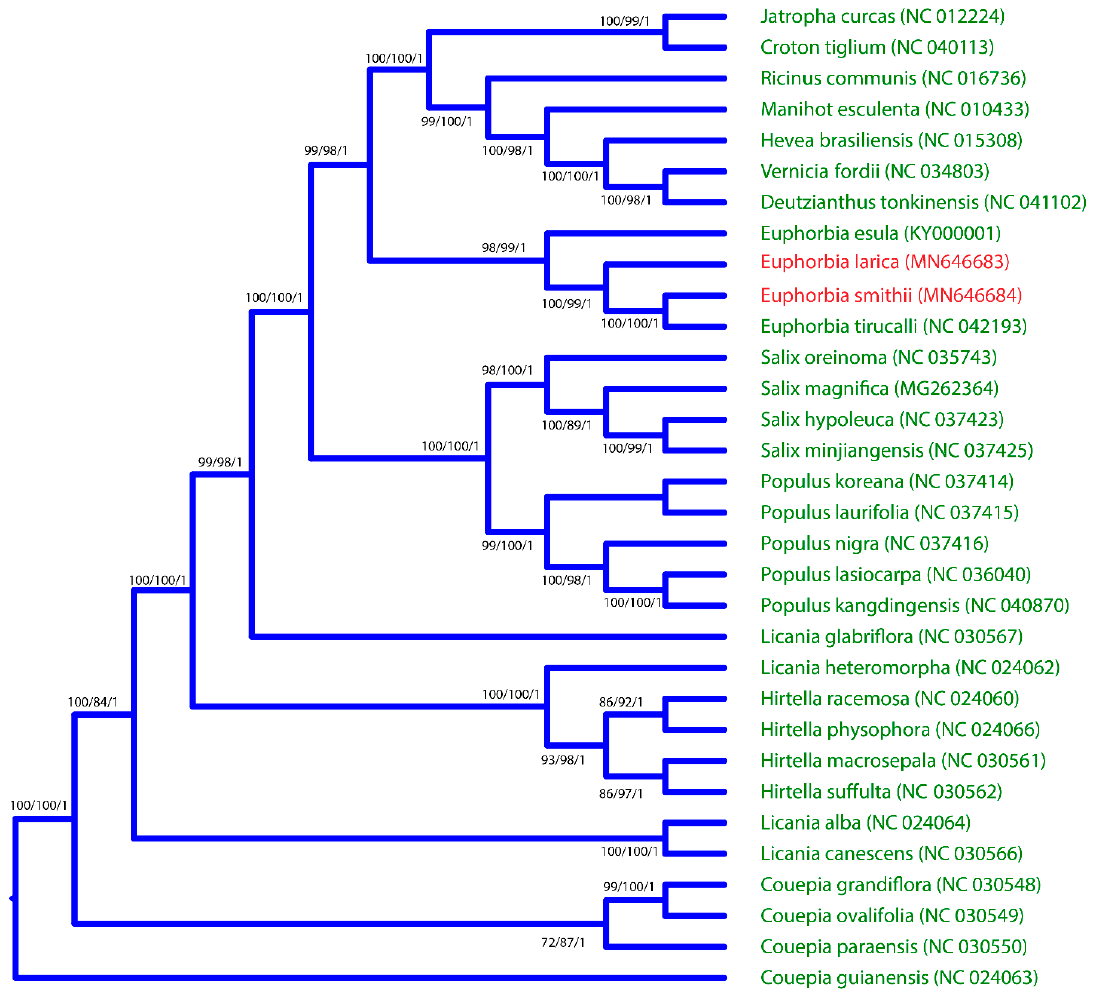
Figure 6. Phylogenetic trees of E. smithii and E. larica . The entire genome dataset was analyzed using three different methods: Bayesian inference (BI), maximum parsimony (MP), and maximum likelihood (ML). Numbers above the branches represent bootstrap values in the ML and MP, and posterior probabilities in the BI trees. Red color represents the positions of E. smithii and E. larica .